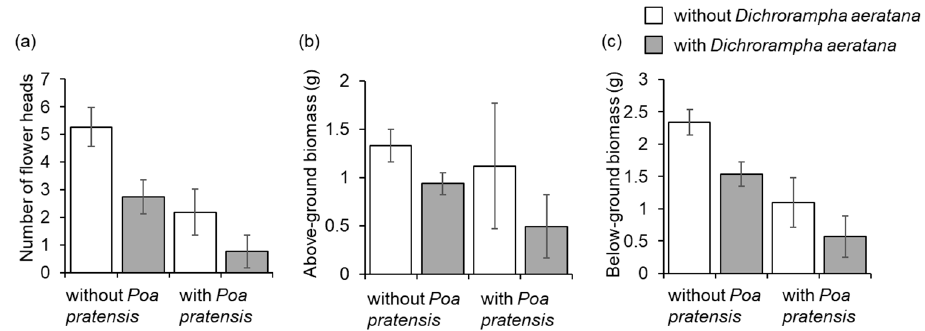
Figure 4. Mean ( ± SE) ( a ) number of flower heads, ( b ) above-ground biomass, and ( c ) below-ground biomass of Leucanthemum vulgare infested with 30 larvae of Dichrorampha aeratana and non-infested plants. Half of the infested and non-infested plants were grown in competition with Poa pratensis. The plants were infested with larvae in April 2013 and measurements were taken in July 2014.